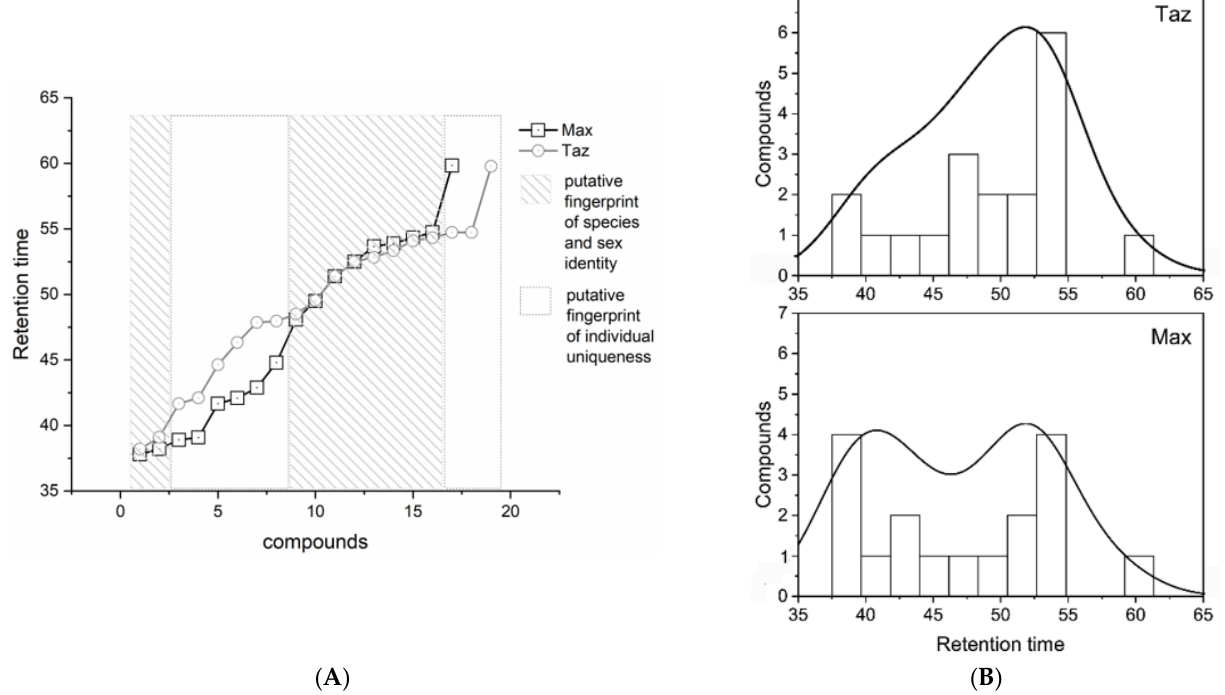
Figure 2. ( A ) Chemical fingerprints of the brown bear’s body reveal species and sex identity with respect to individual uniqueness; ( B ) comparison of the distribution, density, and abundance of individual compounds.